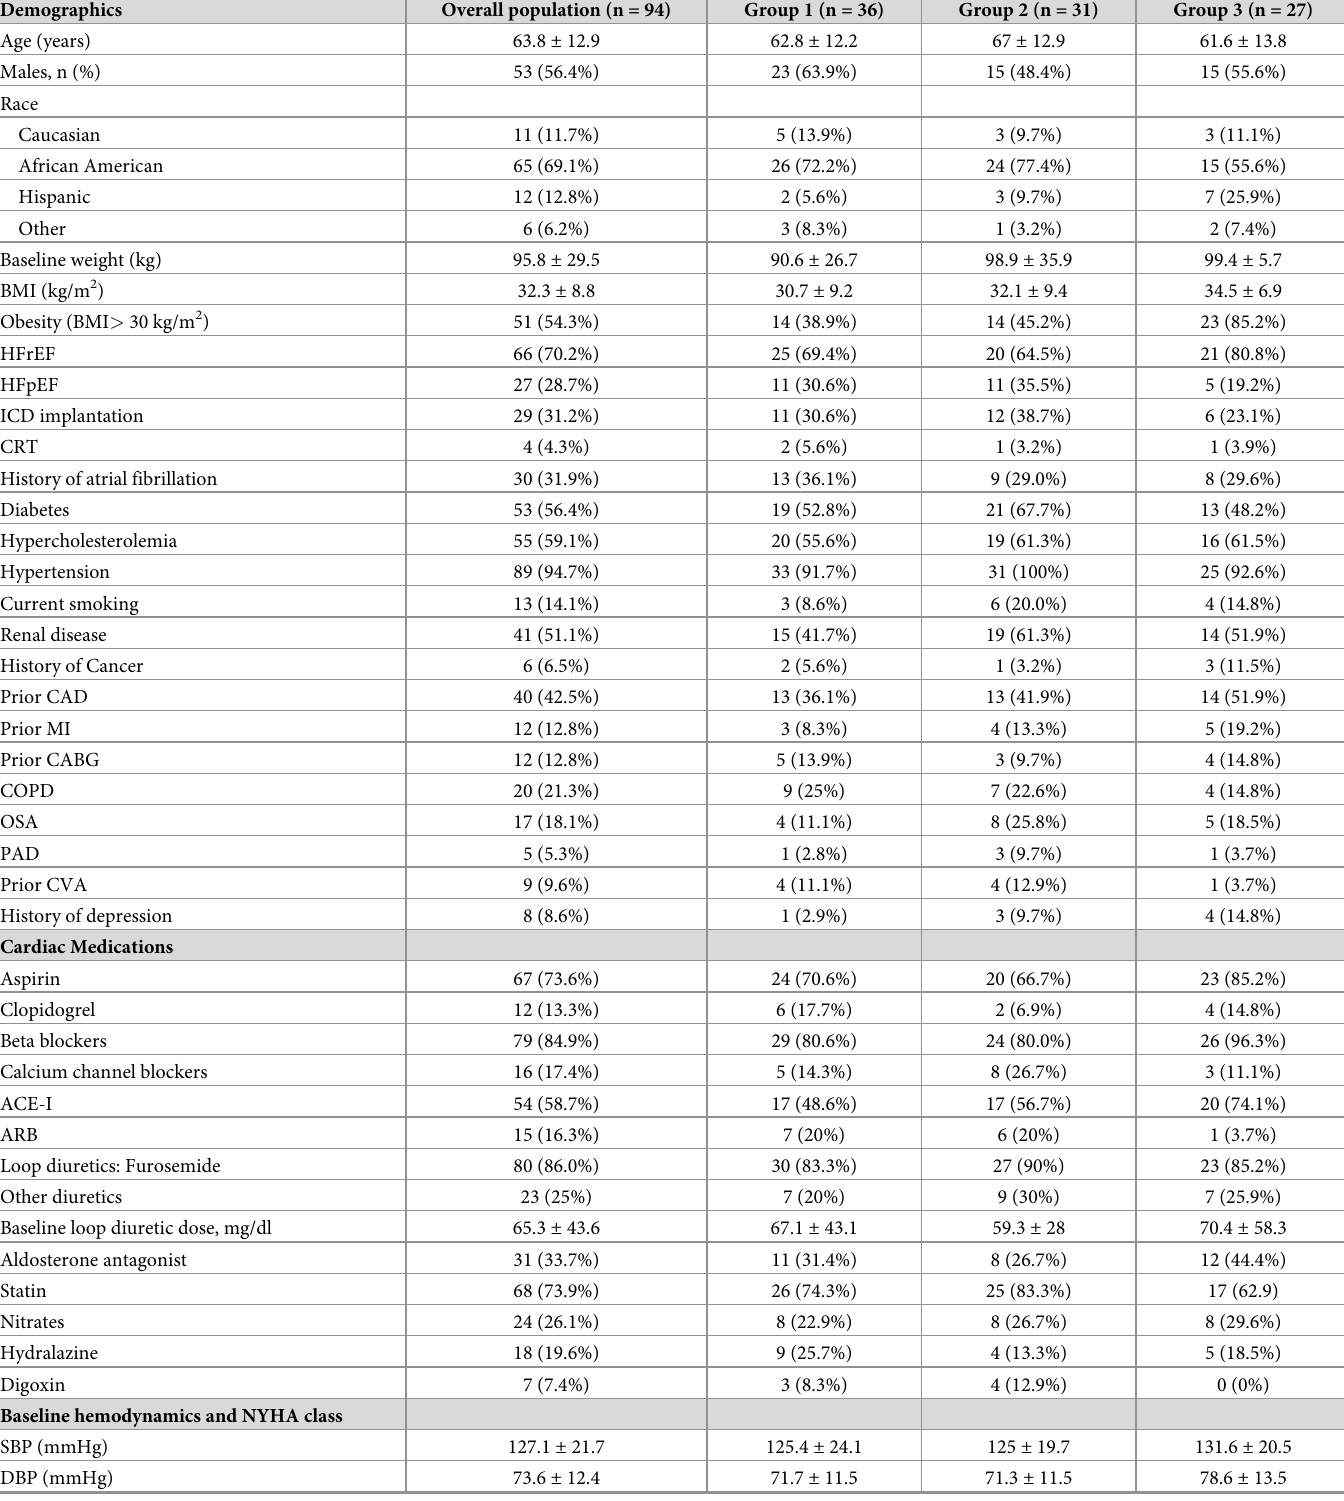
Table 1. Baseline characteristics categorized by treatment